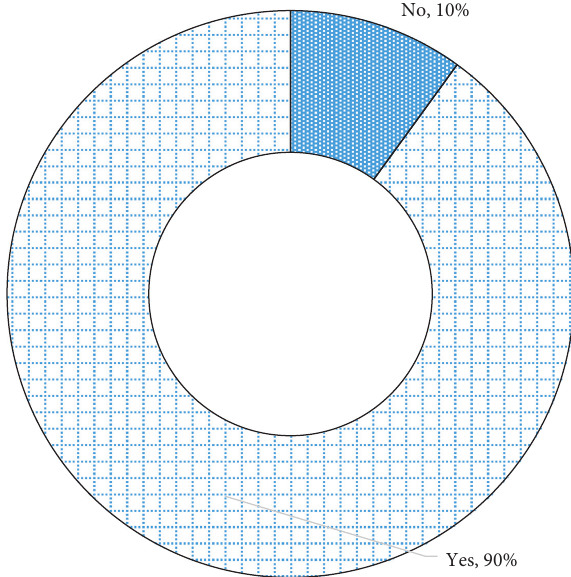
Figure 1: Postnatal care for mothers in URR, Gambia.